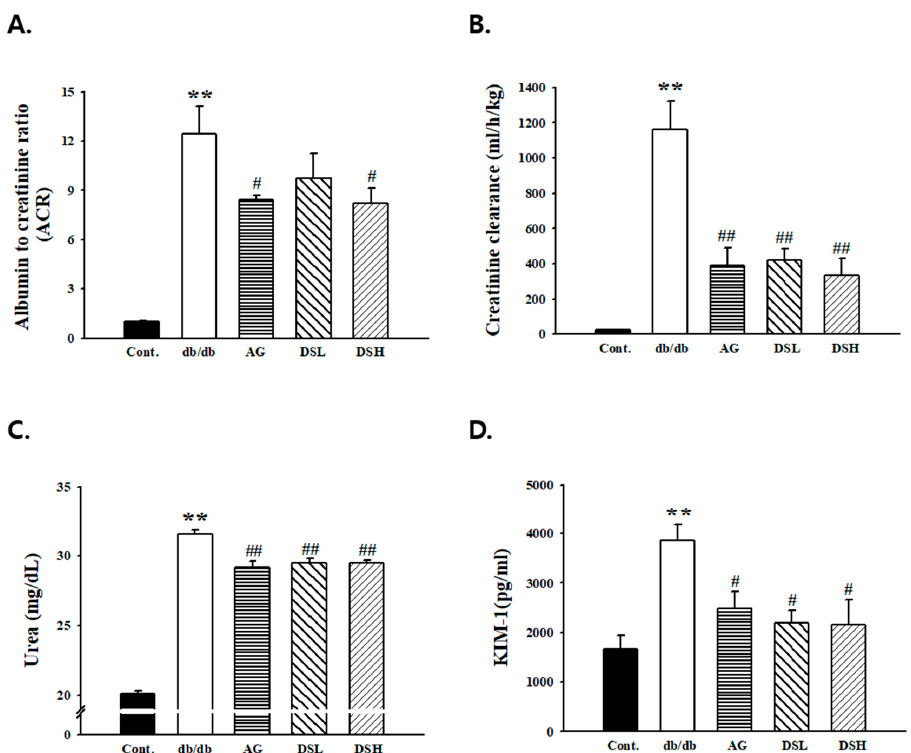
Figure 3. Effect of DS-EA on the albumin-to-creatinine ratio (ACR) ( A ), creatinine clearance ( B ), urine urea ( C ), and KIM-1 ( D ). Values are expressed as mean ± S.E. ( n = 5). ** p < 0.01 vs. Cont.; # p < 0.05, ## p < 0.01 vs. negative Cont.; Cont.: db/m mice group; db/db: db/db mice group (negative Cont.); AG: db/db mice treated with aminoguanidine group; DSL: db/db mice treated with low-dose